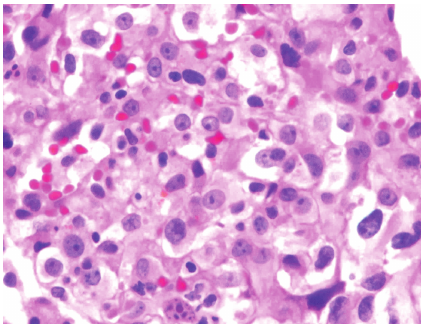
Figure 4: Photomicrograph of thoracoscopic biopsy specimen (hematoxylin-eosin, original × 100) demonstrating pleomorphic endothelial cells with pale cytoplasm, hyperchromatic nuclei, and mitotic